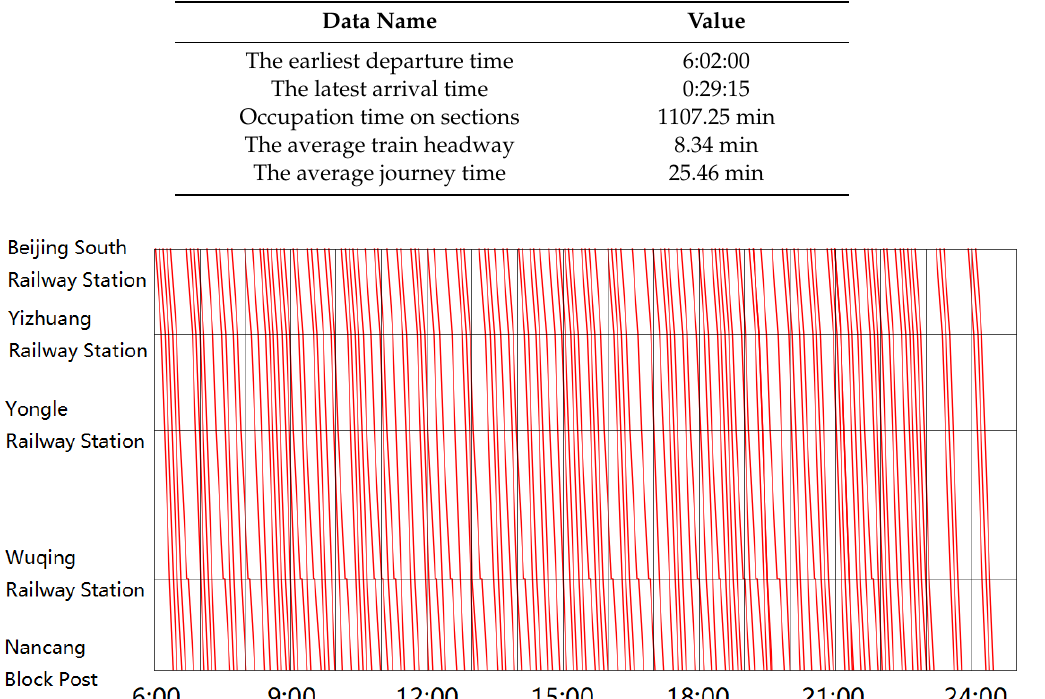
Table 7. Statistical table of some of the relevant data of the original timetable.